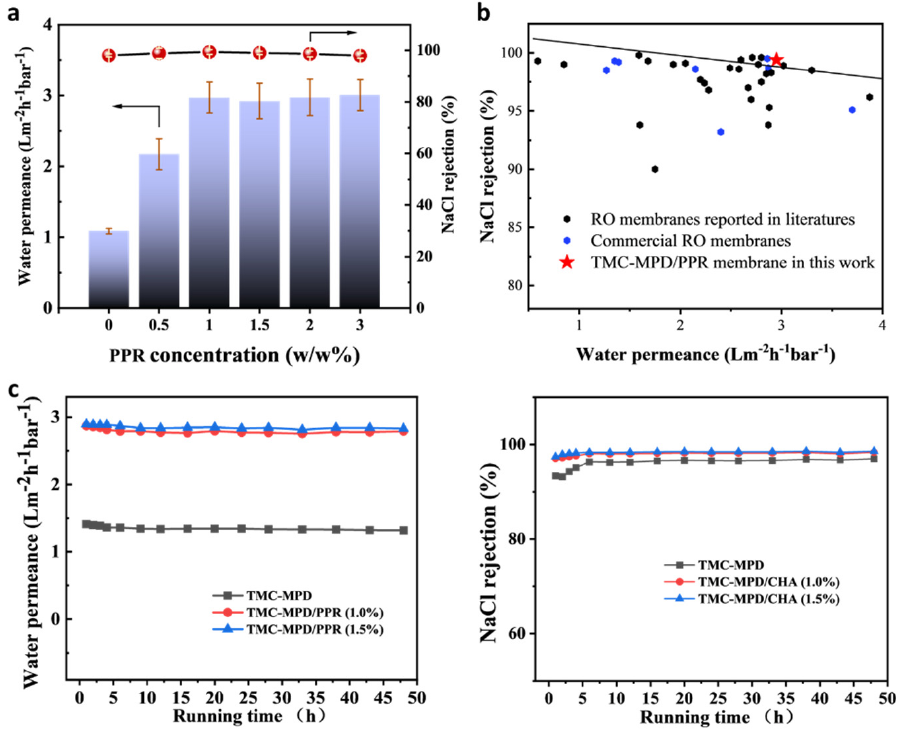
Figure 5. Performance of the fabricated RO membranes. ( a ) Variation of water performance and NaCl rejection of RFRO membranes versus the addition amount of PPR; ( b ) comparison of our fabricated RO membranes with commercial RO membranes and other advanced RO membranes reported recently; the line is the upper bound of performance, which was established based on the majority of the selected data; ( c ) operation stability test of the fabricated membranes.